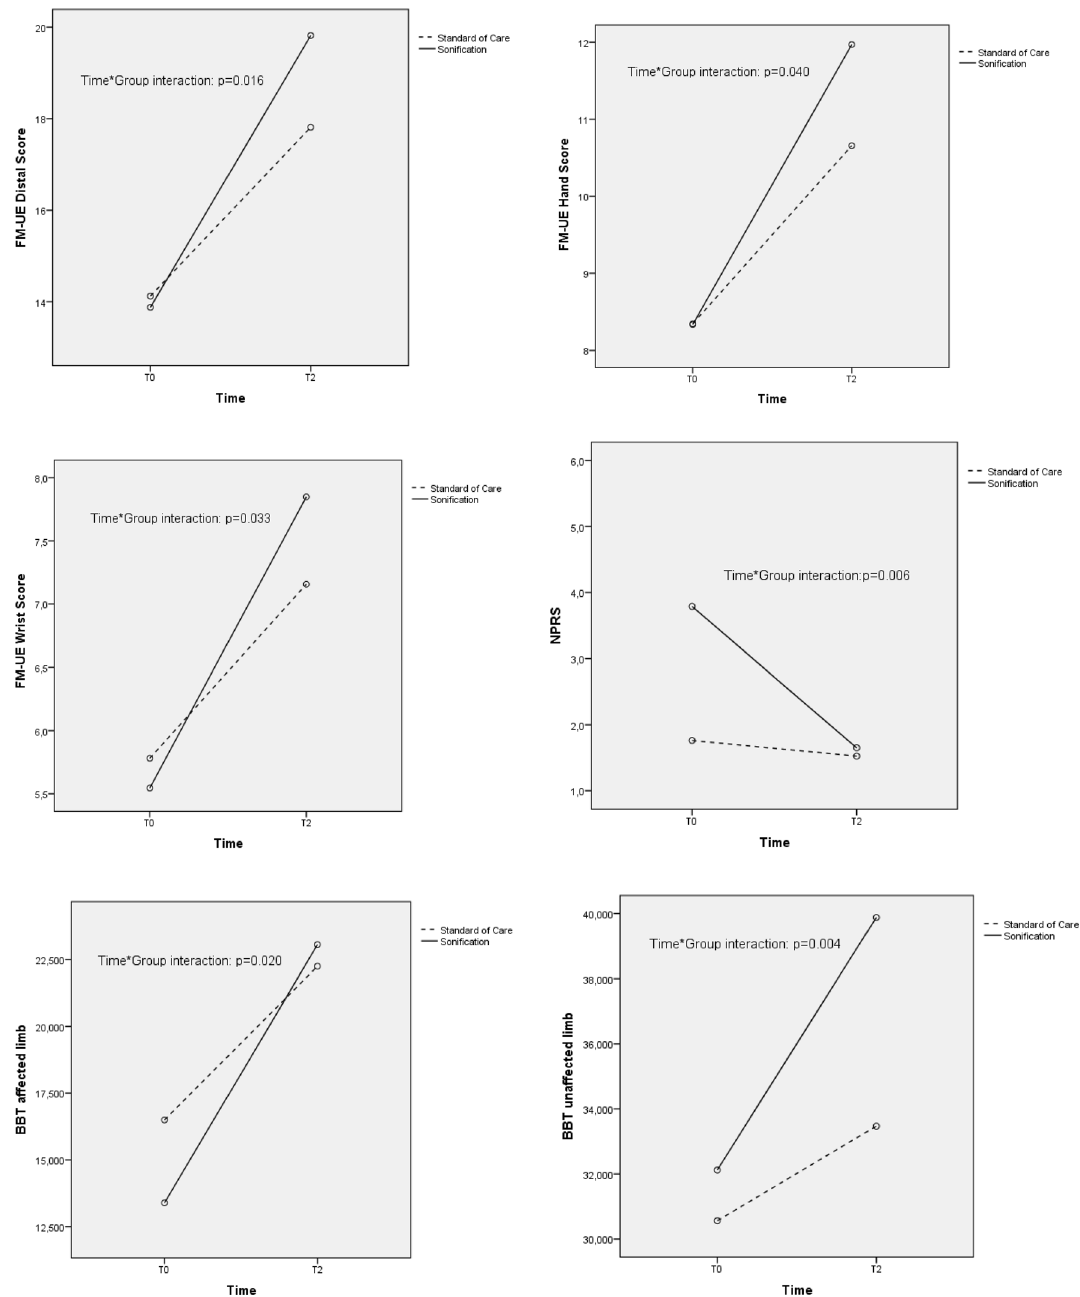
Figure 3. Trend between baseline (T0) and end of treatment (T2, 4 weeks) of secondary